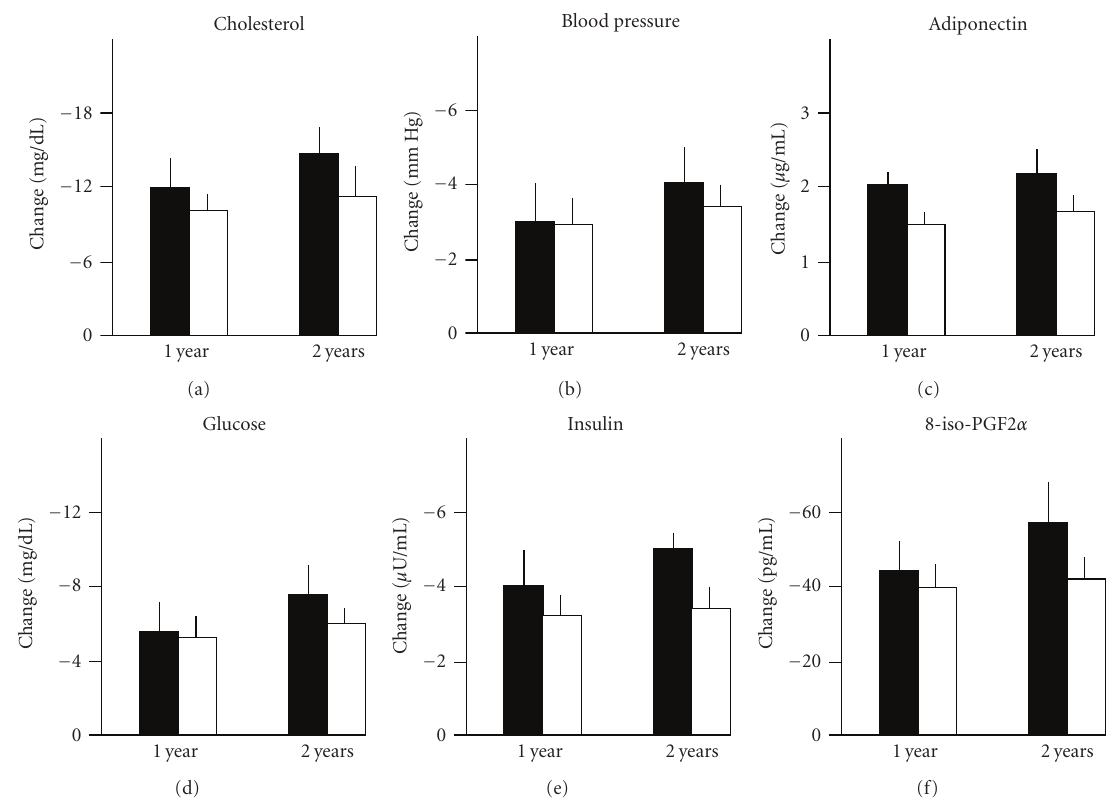
Figure 1: Changes in fasting plasma total cholesterol, glucose, insulin, mean blood pressure, insulin, adiponectin, and 8-iso-PGF 2 α levels at year 1 and year 2 in subjects of intervention groups (black columns: lifestyle, white columns: MED diet). All parameters represent the net e ff ect (intervention group, advice group) of treatments and were significantly reduced from baseline values at year 1 and year 2 in both